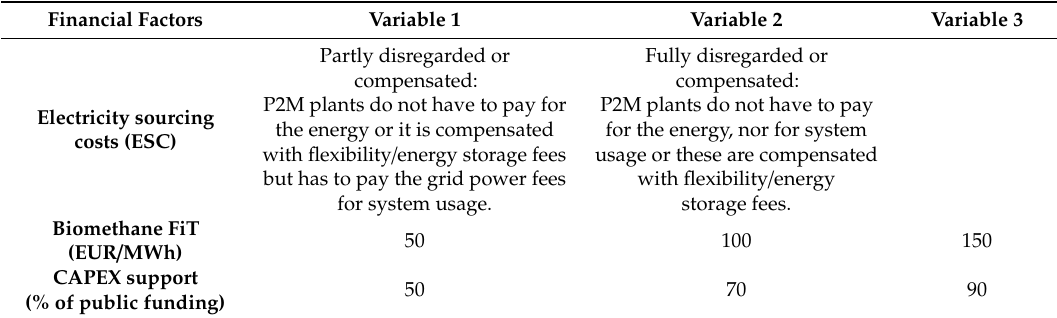
Table 2. Specific variables for financially attractive scenario generation for